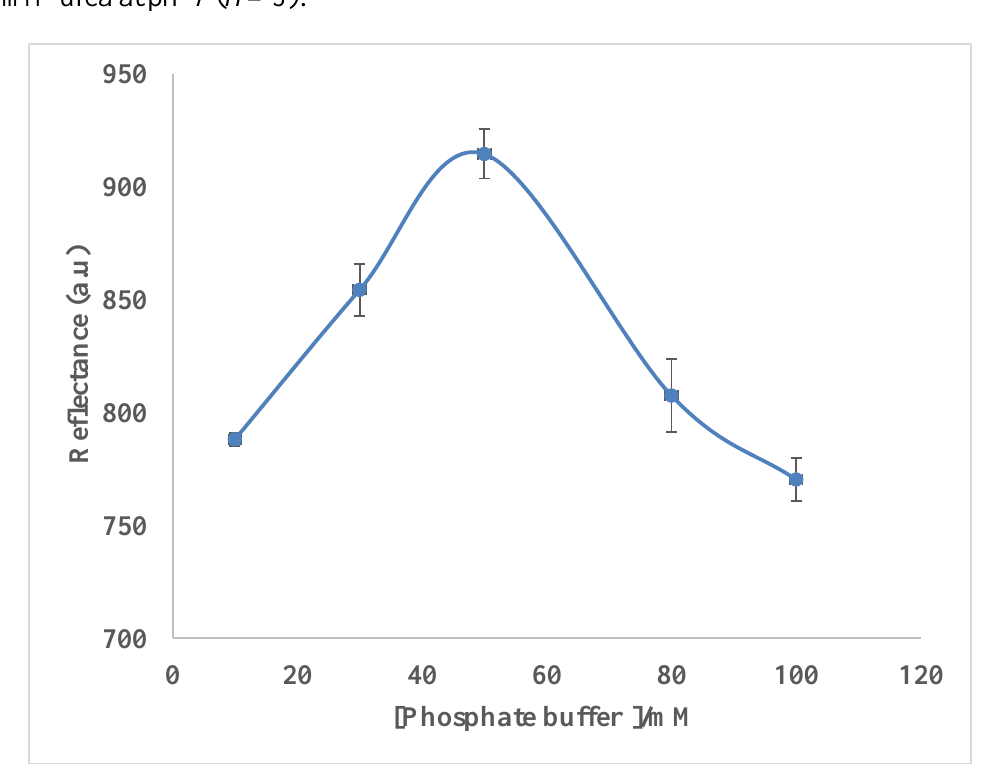
Figure 8. Effect of buffer concentration on urea biosensor response at 650 nm using 300 mM urea at pH 7 ( n =